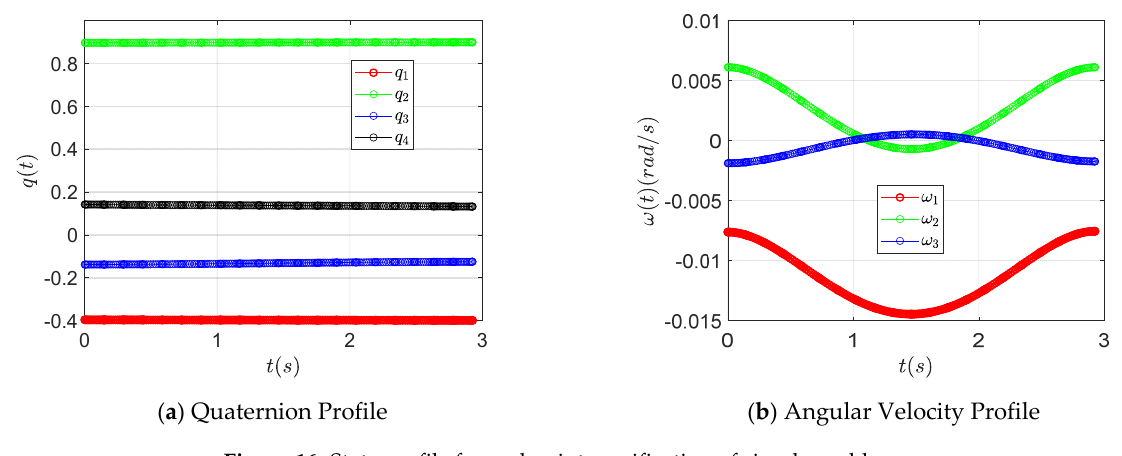
Figure 16. State profile for end points verification of simple problem.